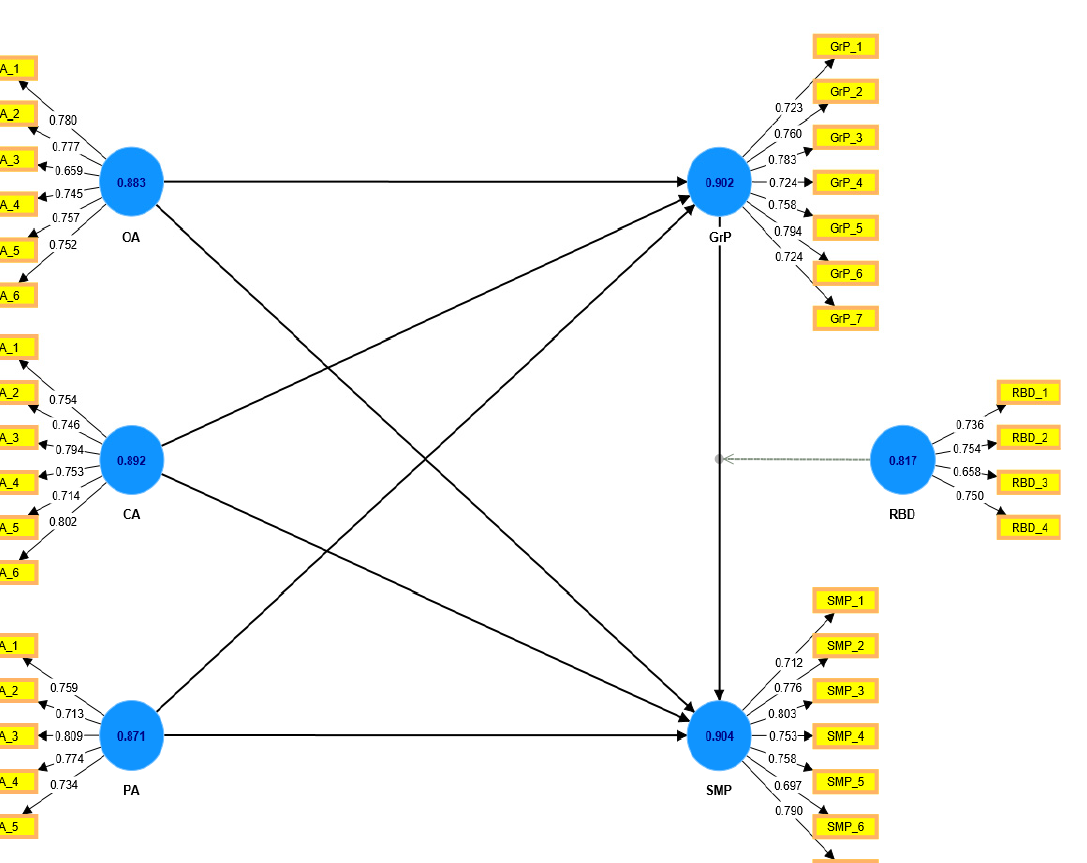
Table 2. Discriminant Validity Analysis (Fornell Larcker and HTMT). Constructs